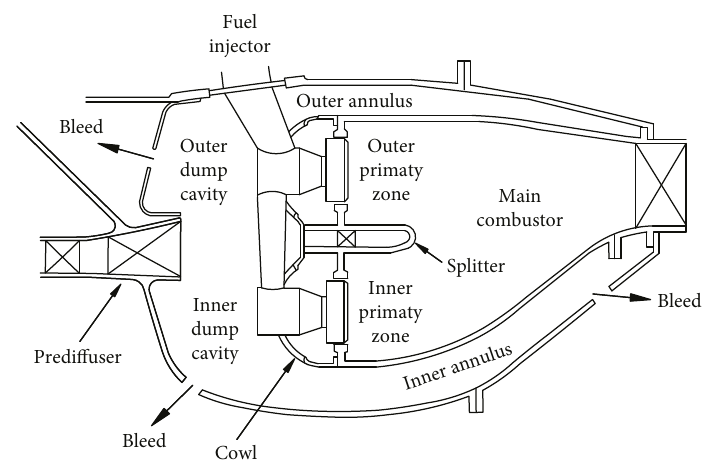
Figure 1: Bleeding program.